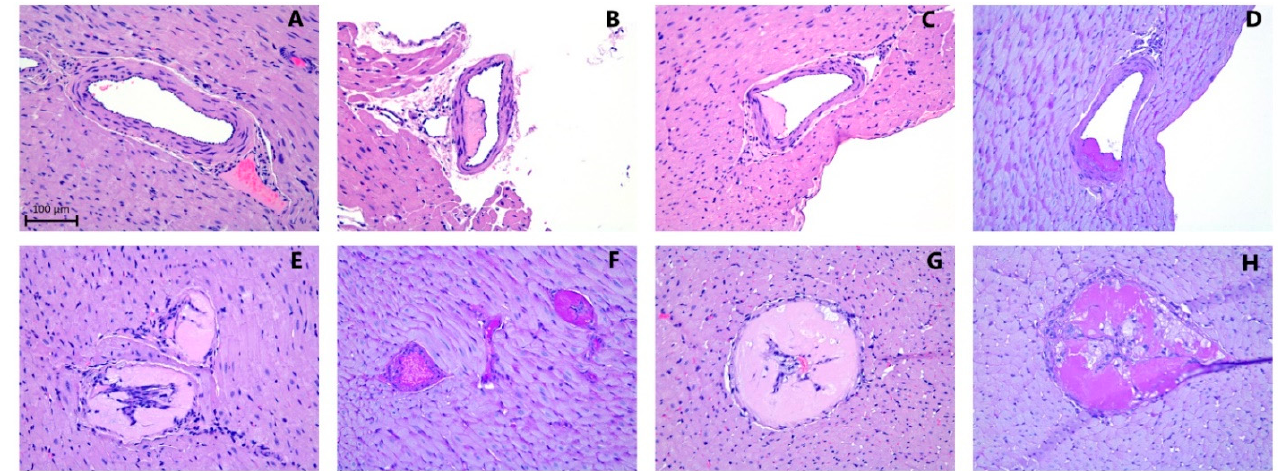
Figure 5. Representative examples of coronary arteries from guinea pigs fed with ( A ) control diet sufficient with vitC (CTRL); atherosclerotic lesions from coronary artery sections ( B , E , F ) following a fed high-fat diet sufficient in vitC (HFD) or ( C , D , G , H ) from animals fed a high-fat diet with low vitC (HFDLoC); ( A – C , E , G ) H&E and ( D , F , H ) PAS staining. Scale bar =100 µ m.